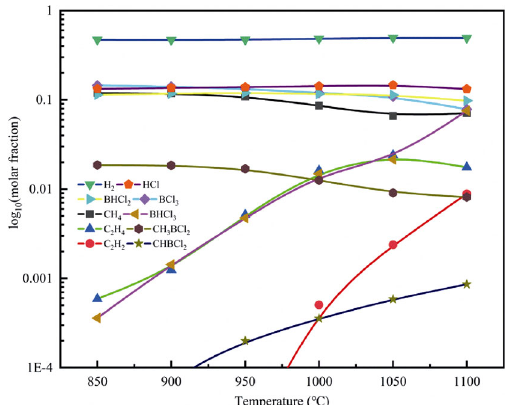
Fig. 5 Influence of temperature on the mole fraction of intermediate components: Total pressure of 12 kPa, total gas flow rate of 210 sccm, In_BCl 3 is 2/7, and In_CH 4 is 1/7.